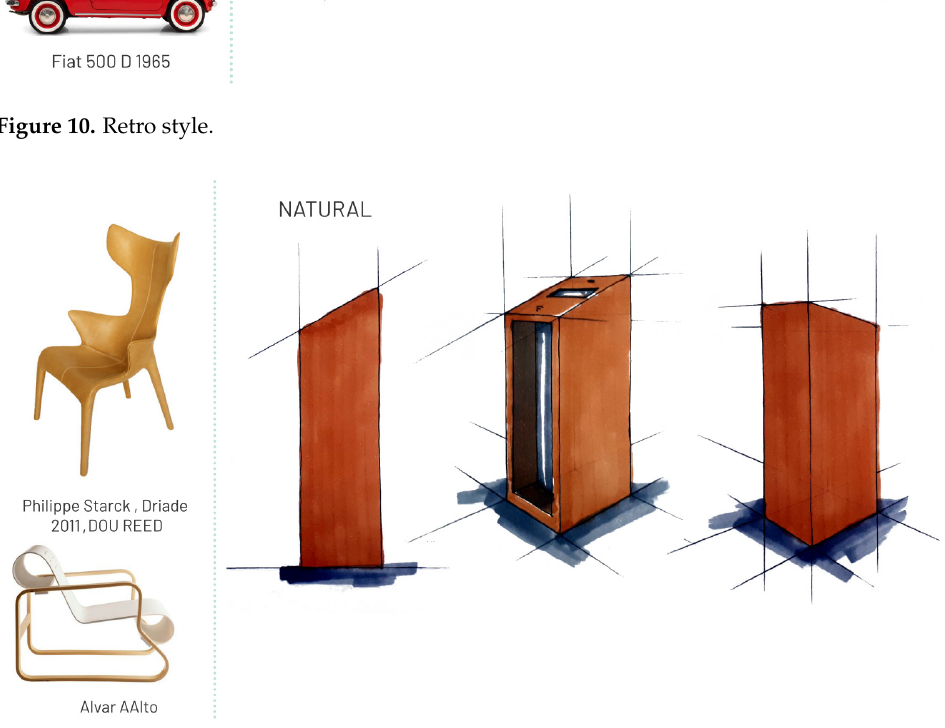
Figure 11. Natural style.